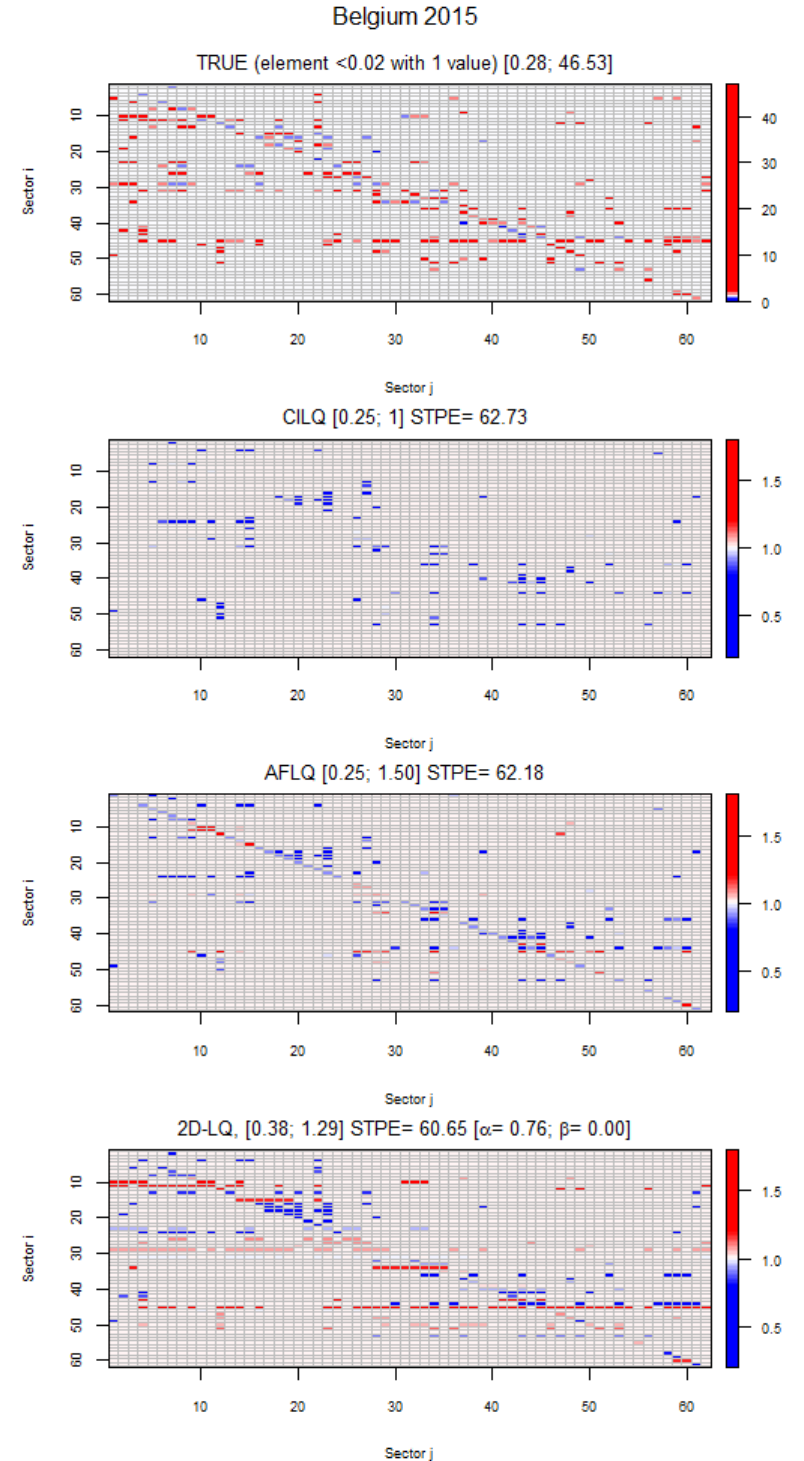
Figure 3. Projections of technical coefficients via LQ versus ideal rectifications (Belgium). Source: internal based on Eurostat data [naio_10_cp1700].